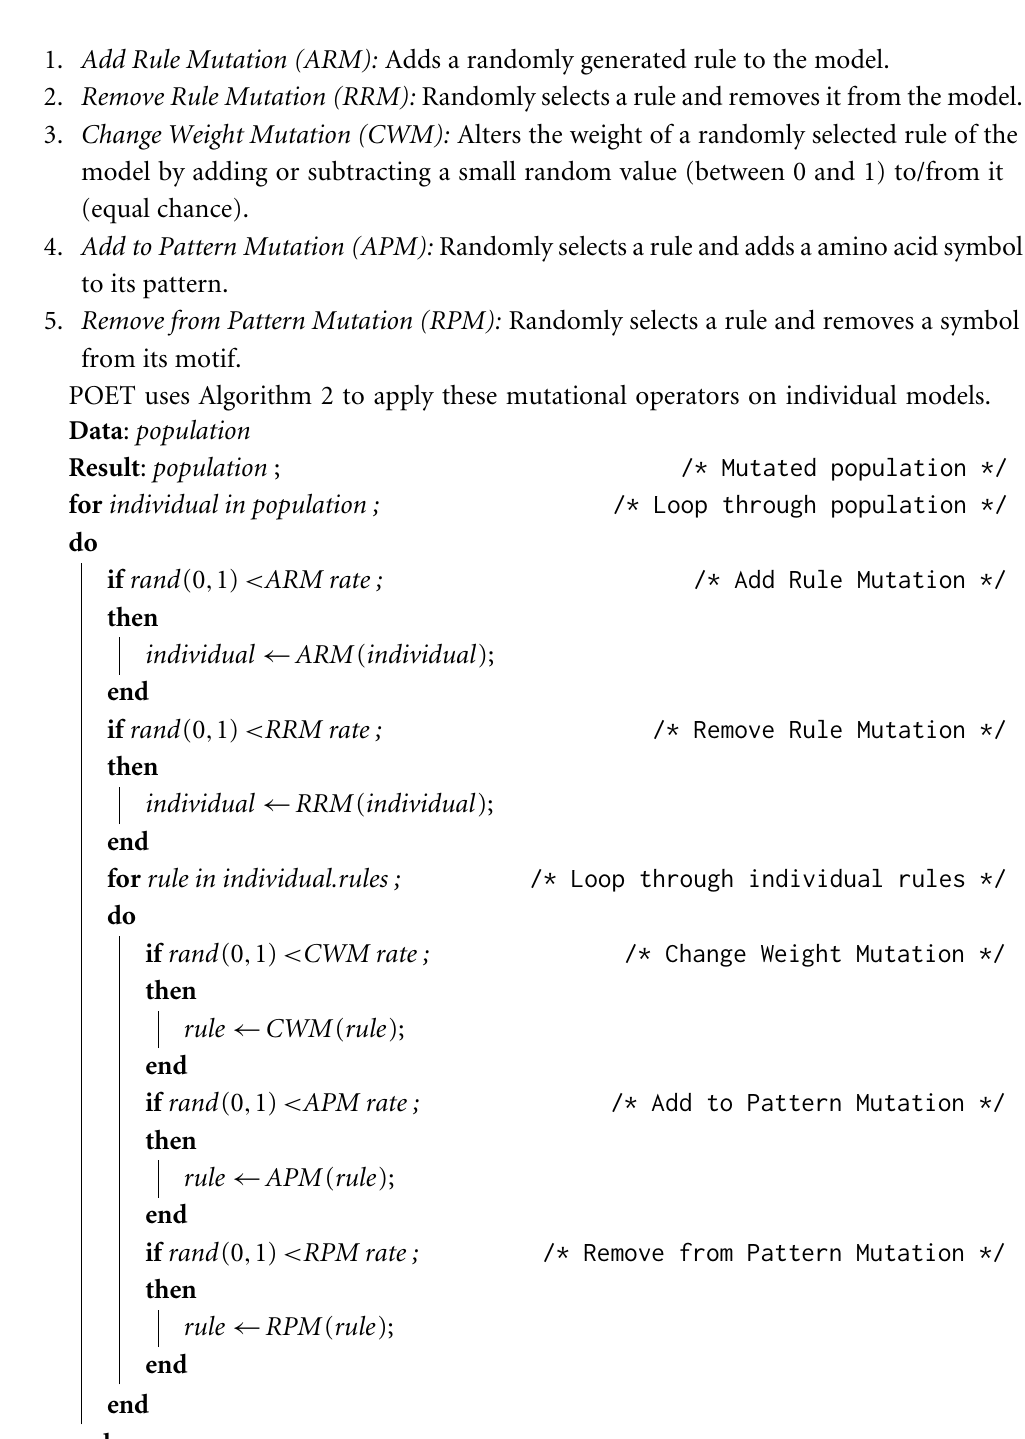
Algorithm 2: Pseudo-code of the mutation evolutionary operator of POET. ARM and RRM happen on individual models, while CWM, APM, and RPM can mutate every rule of an individual. Each of these mutational operators has a configurable mutation